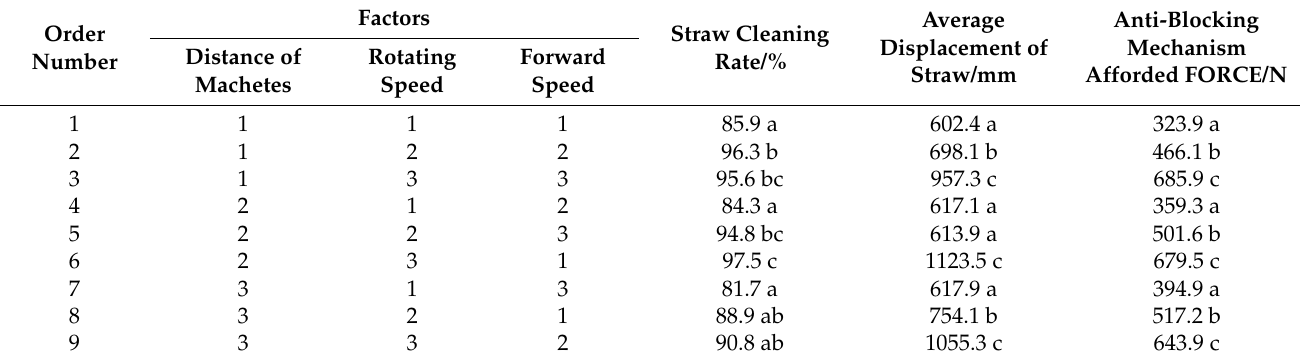
Table 3. Results of the EDEM simulation. Note: Values within a column followed by the same letters are not significantly different at p =